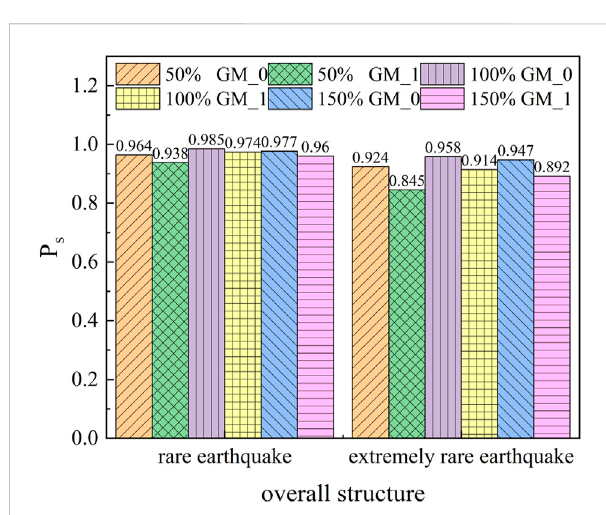
omparison of overall reliability probability with different bearing